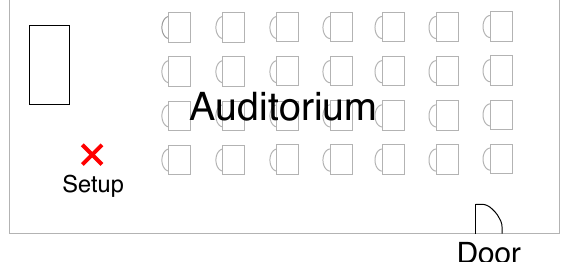
Figure 2. Indoor Scenario: Auditorium acoustically isolated without external audio